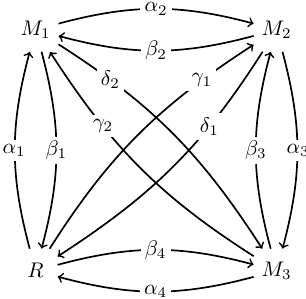
Figure 10. The NCCR of R = C [ x; y; z; t ] =